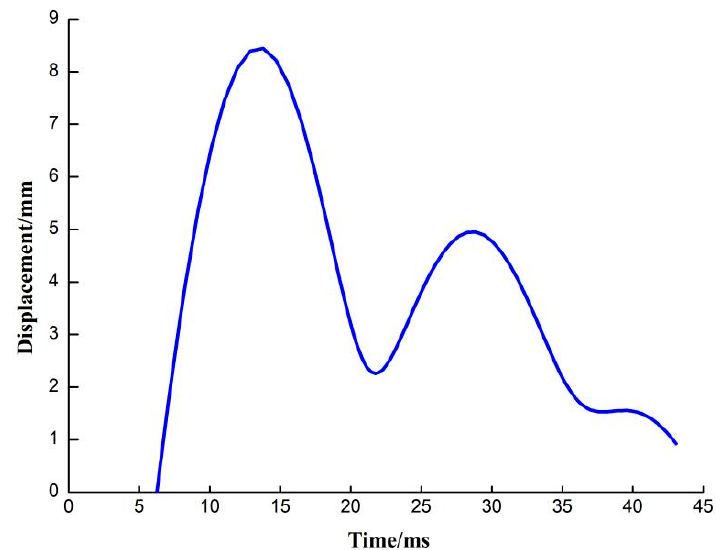
Figure 9. Displacement of the pump valve obtained from the U-Adolph prediction.